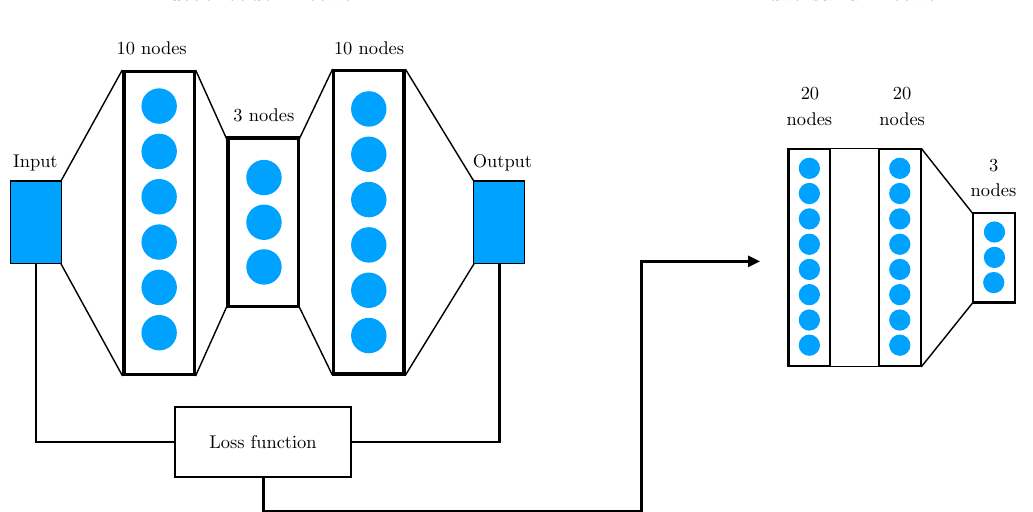
Figure 5. Architecture of the adversarial autoencoder. The loss function of the autoencoder is used as an input to the adversary for it to discriminate the smeared background